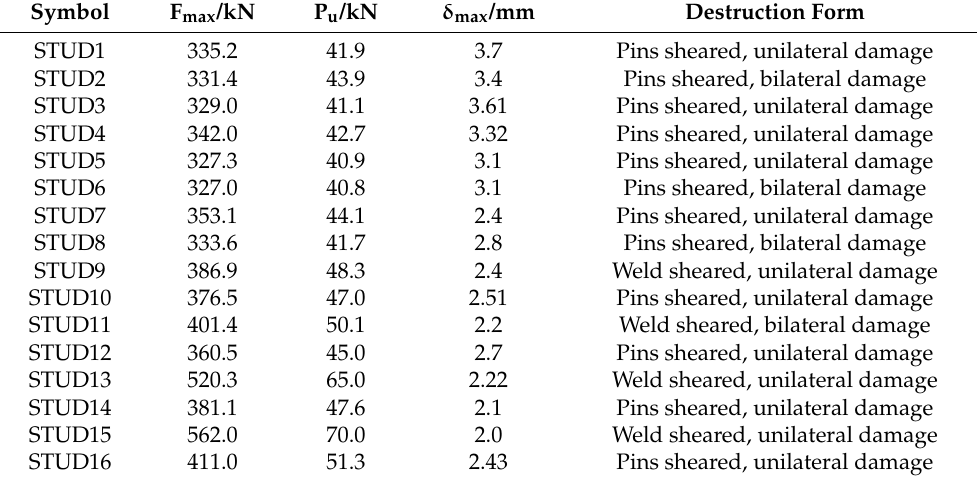
Table 5. Main results of the test.